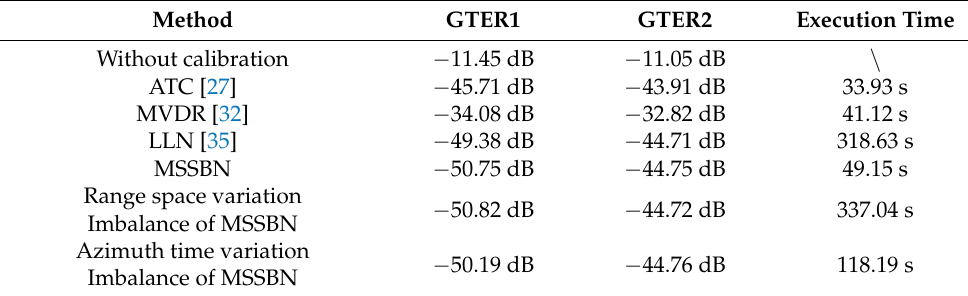
Table 8. GTER of different